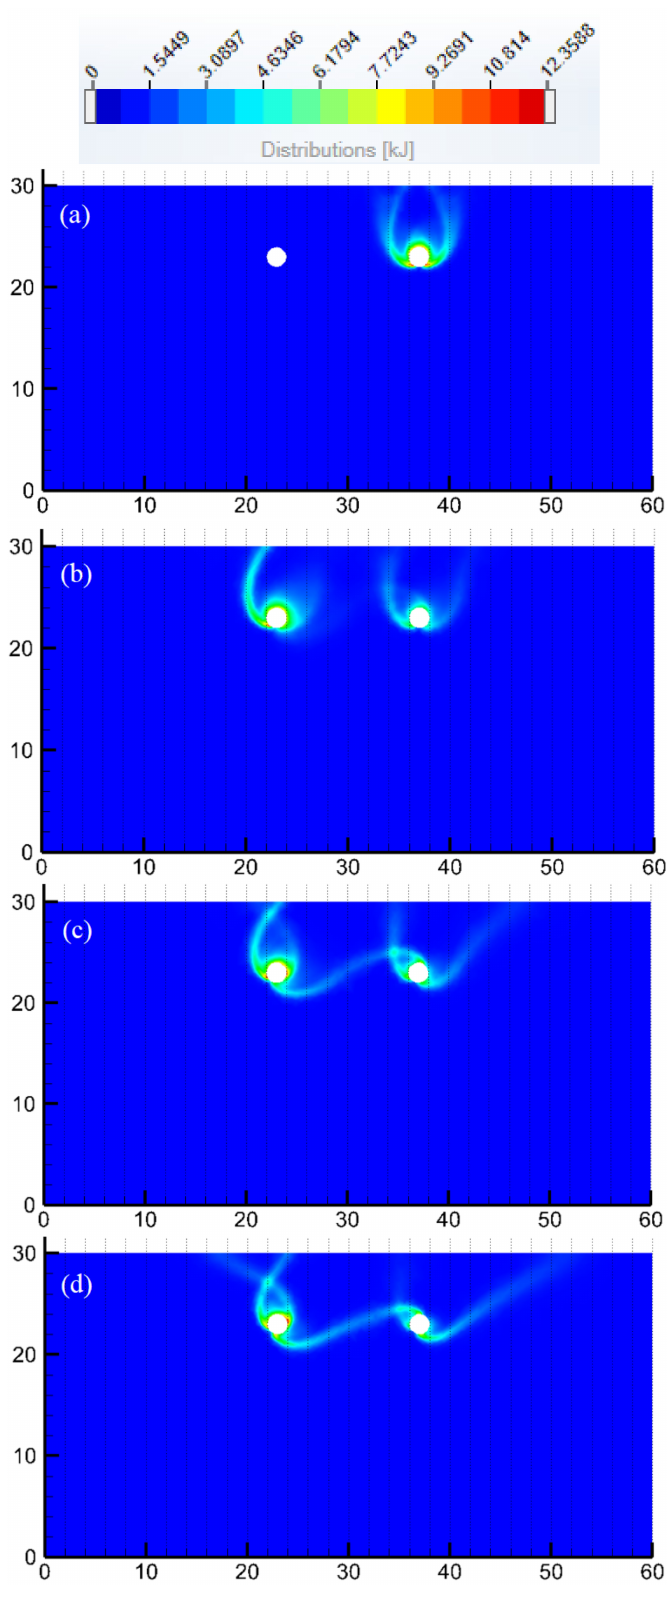
Figure 11. Upper bound failure mechanisms with S / D = 7, H / D = 3, γ D / c = 1, and ϕ = 10 ◦ for ( a ) k h = 0; ( b ) k h = 0.1; ( c ) k h = 0.2; and ( d ) k h =